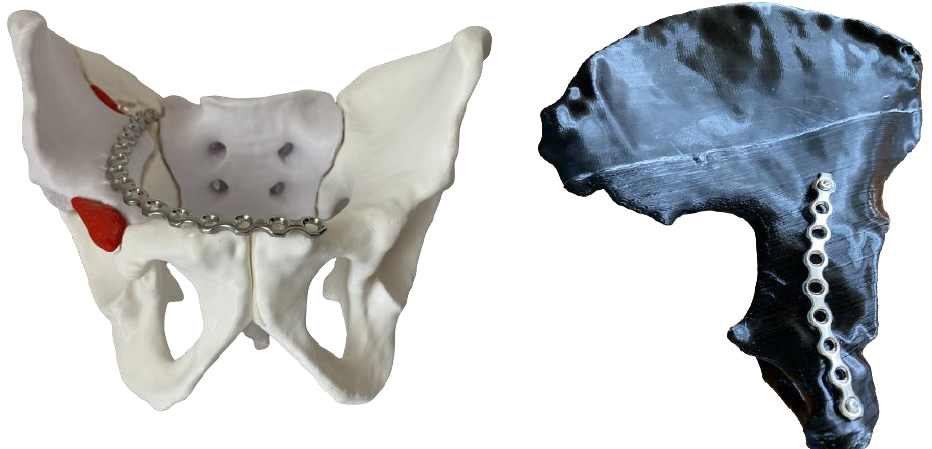
Figure 3. A 3D printed pelvis model of a patient with a preoperatively contoured anterior column plate, placed after fracture reduction, with no fixation of the iliac ring ( left ); a 3D printed model of a hemipelvis from another clinical case, generated via mirroring of the uninjured contralateral side, and visualized with a posterior column plate with temporary fixation ( right ).